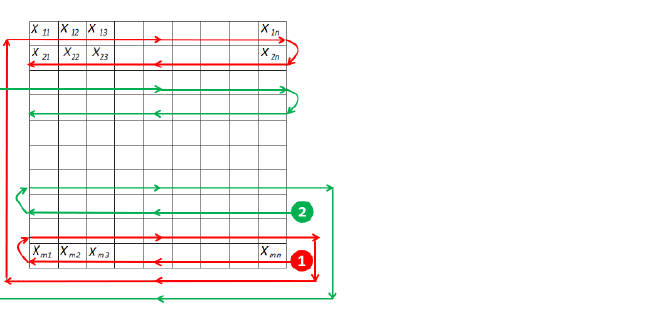
Figure 3. Visiting scheme of the SMMRF adopted in each layer of the first proposed method